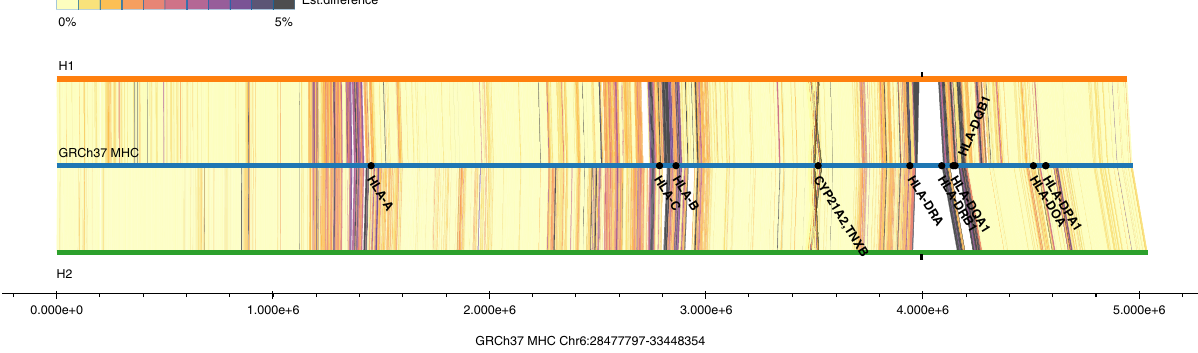
Fig. 2 Alignments of the two main haplotigs to the primary GRCh37 MHC region. We compute the local divergence (est. difference) of the HG002 MHC haplotigs to the MHC of GRCh37 by performing local alignment. The differences between the assembled contigs to the references are computed using sequence blocks anchored with minimers and aligned locally using an O(ND) alignment algorithm 33